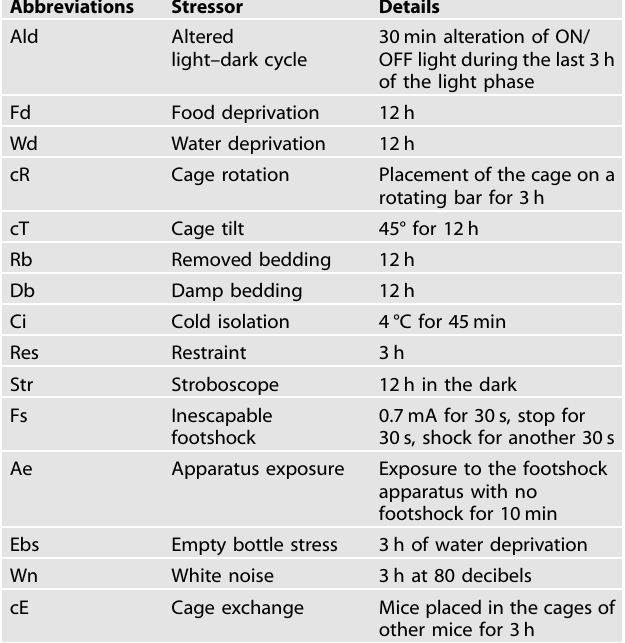
Table 1. Details and abbreviations of the